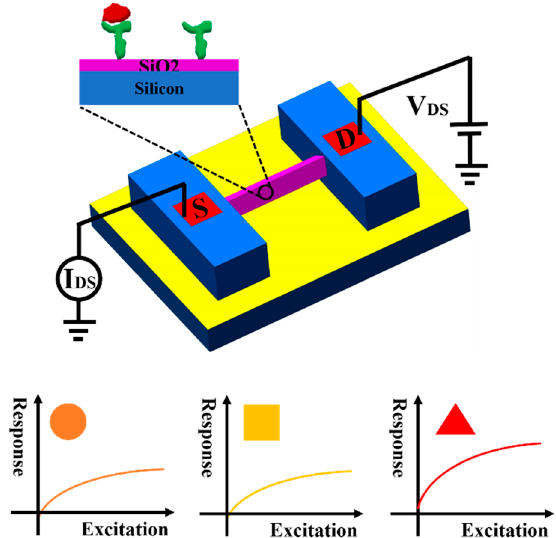
Figure 1. The sensitivity of three types of SiNWs-FET sensors with circular, square and triangular cross-sections.